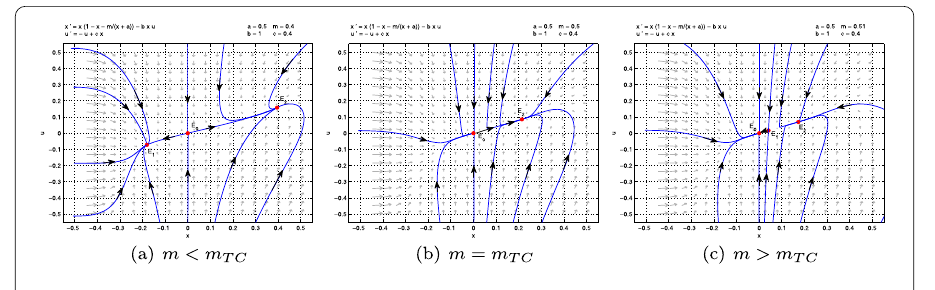
Figure 5 The transcritical bifurcation of system